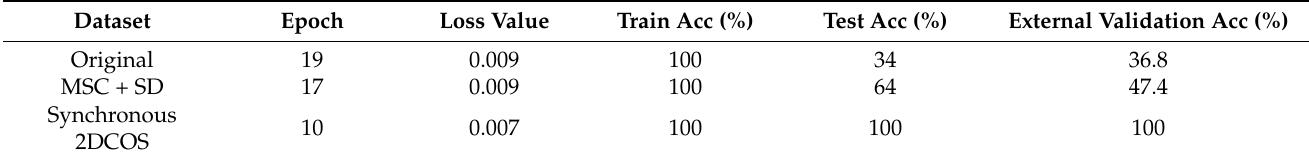
Table 4. Parameters of ResNet Model Based on